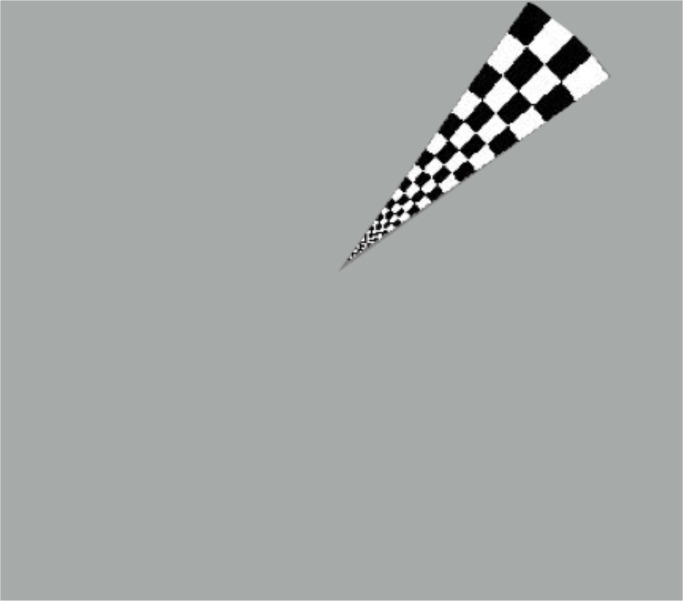
Polar angle visual stimuli used during functional magnetic resonance imaging scanning.